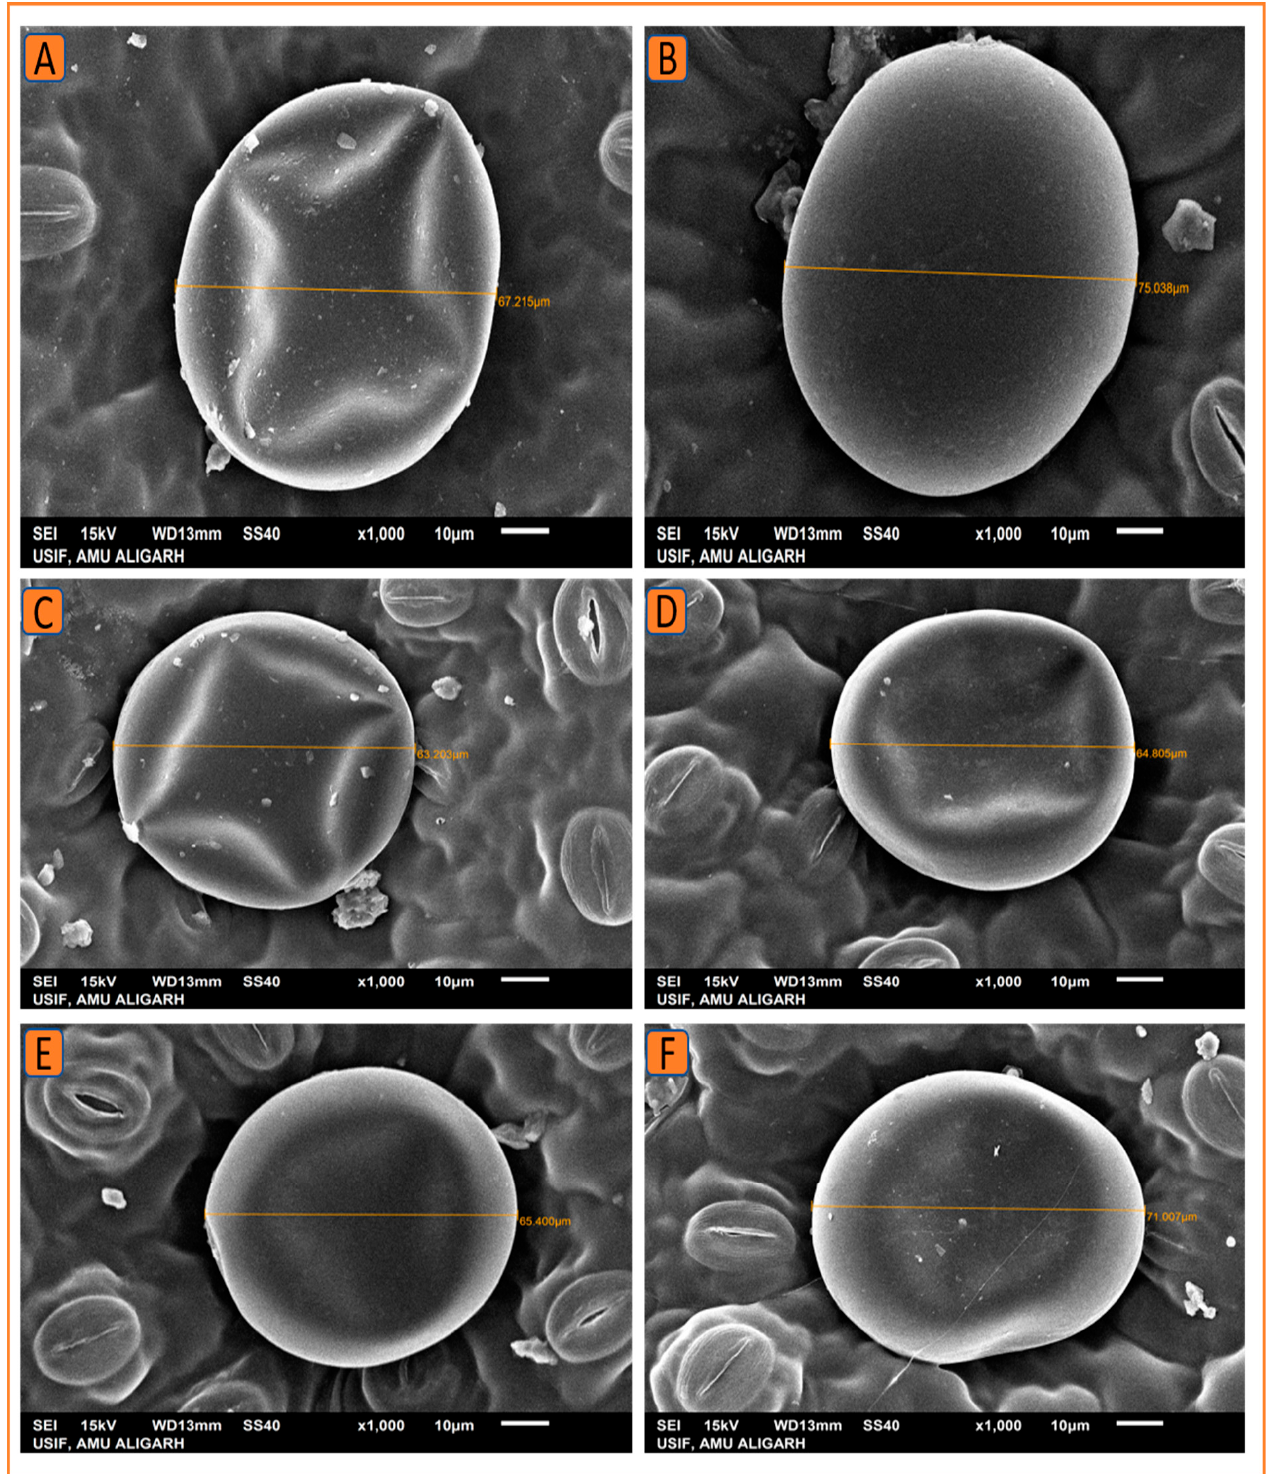
Figure 11. SEM micrographs showing the trichome size in the three studied cultivars of peppermint. The SEM micrographs show an enhancement in trichome size in all three cultivars by N application. ( A ) Trichome size at 0% N in Kukrail, ( B ) at 1.5% N in Kukrail, ( C ) at 0% N in Pranjal, ( D ) at 1.5% N in Pranjal, ( E ) at 0% N in Tushar, ( F ) at 1.5% N in Tushar.